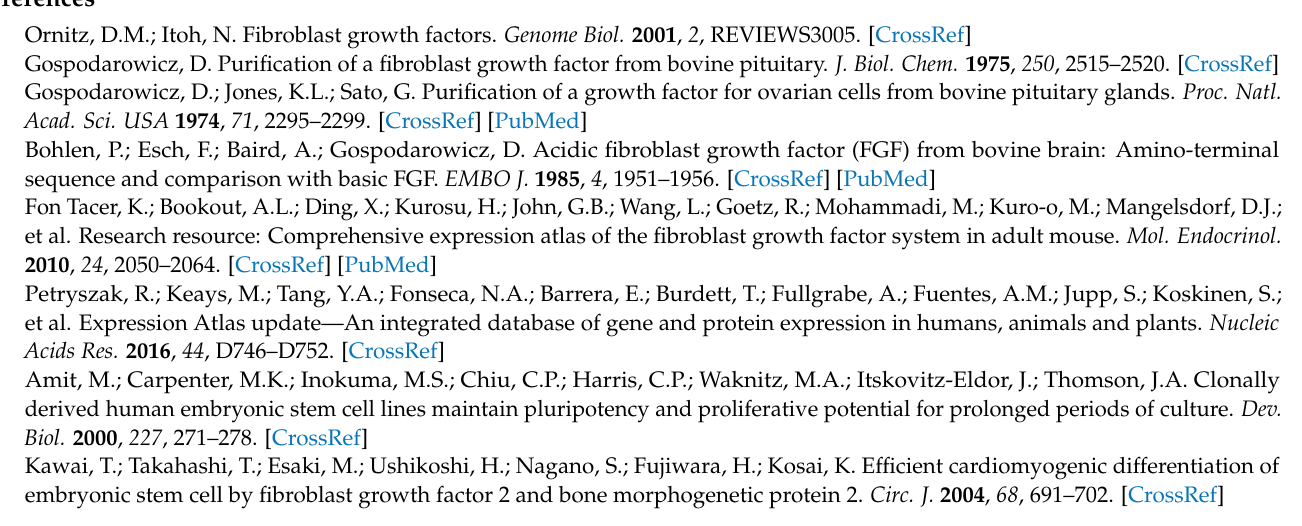
in male ( ) and female ( ♂